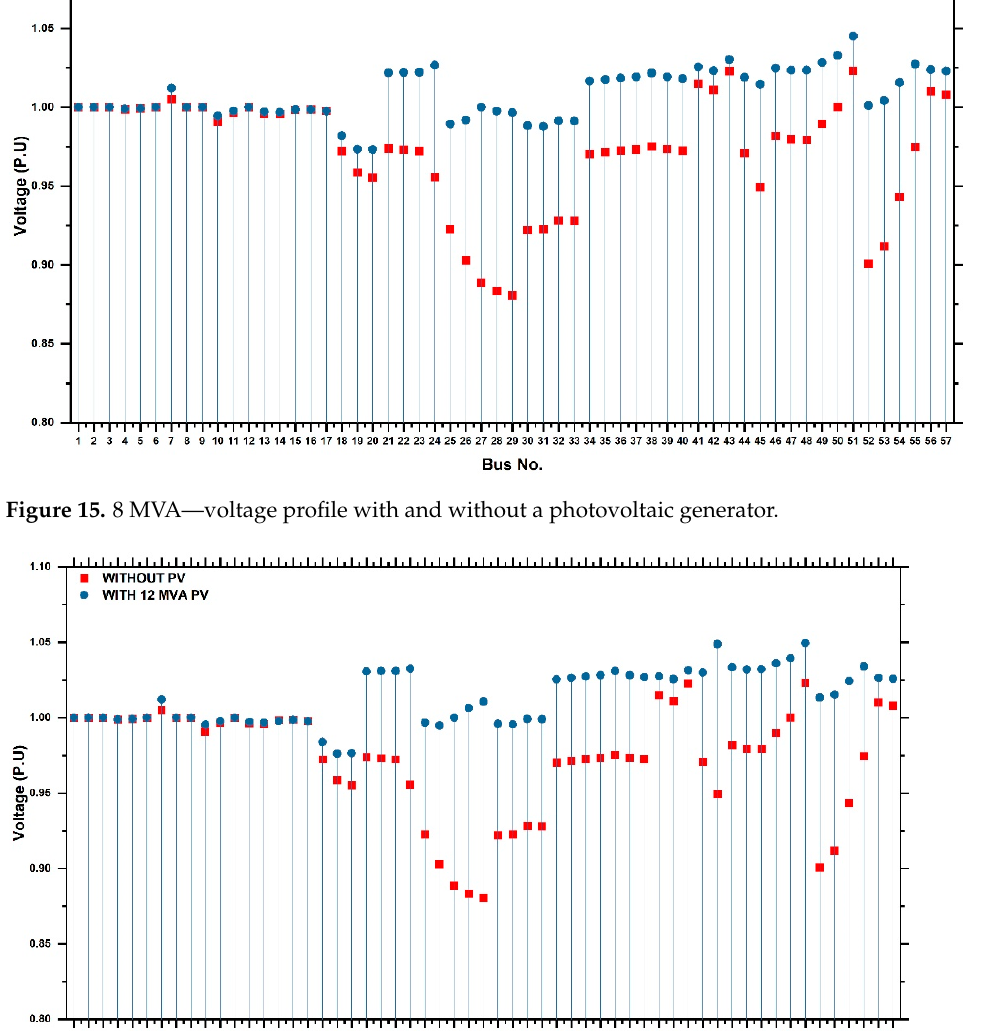
Figure 15. 8 MVA—voltage profile with and without a photovoltaic generator.